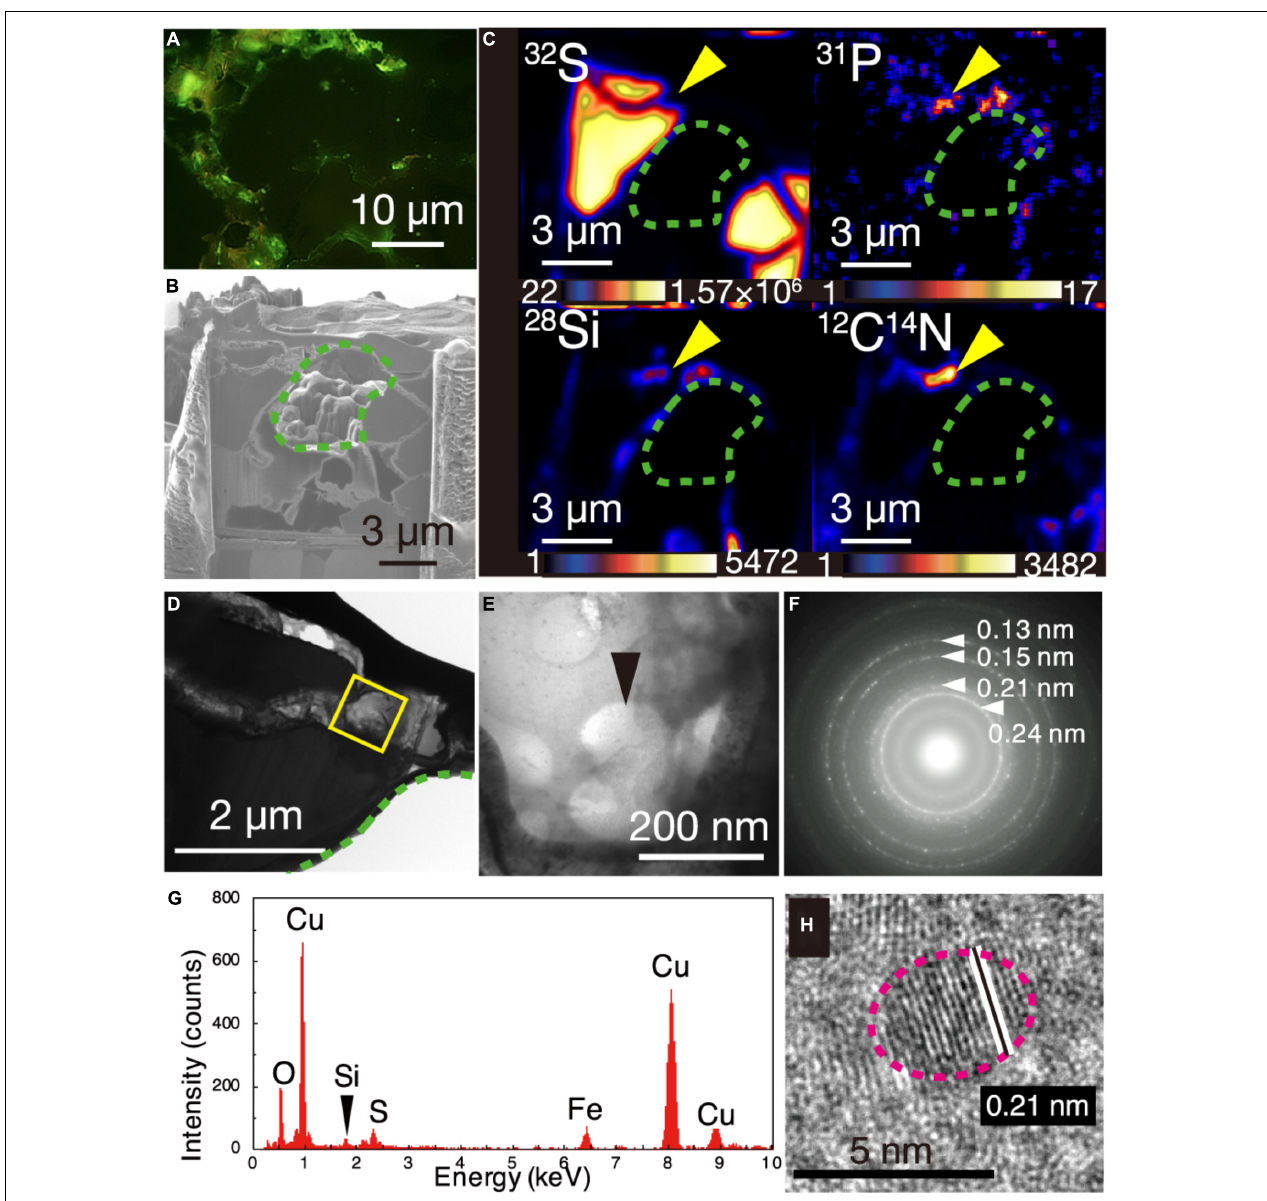
FIGURE 2 | Visualization of microbial cells associated with Cu-bearing nanocrystals in chalcopyrite grain boundaries. (A) Fluorescence microscopy image of a grain boundary with greenish cell-like signals where a 150-nm thick FIB section was fabricated. (B) Ga ion image of a 150-nm thick FIB section of the grain boundary shown in (A) . A green dotted line shows a hole corresponding to chalcopyrite grains in the FIB section. (C) NanoSIMS images of the 150-nm thick FIB section with intensity color contours. Yellow arrows indicate the region presented in (E) . (D) TEM image of a ribbon-shaped grain boundary of a 150-nm thick FIB section. A yellow square indicates the same region presented in (E) . (E) TEM image of small spheres. (F) Selected area electron diffraction pattern from the small spheres in (E) . Arrows indicate ring patterns with interplanar spacings. (G) Energy dispersive X-ray spectrum from the small spheres. (H) High-resolution TEM image of crystalline nanoparticles in the region pointed by a black arrow in (E) . White lines indicate lattice fringes of a nanocrystal with the rim indicated by a pink dotted